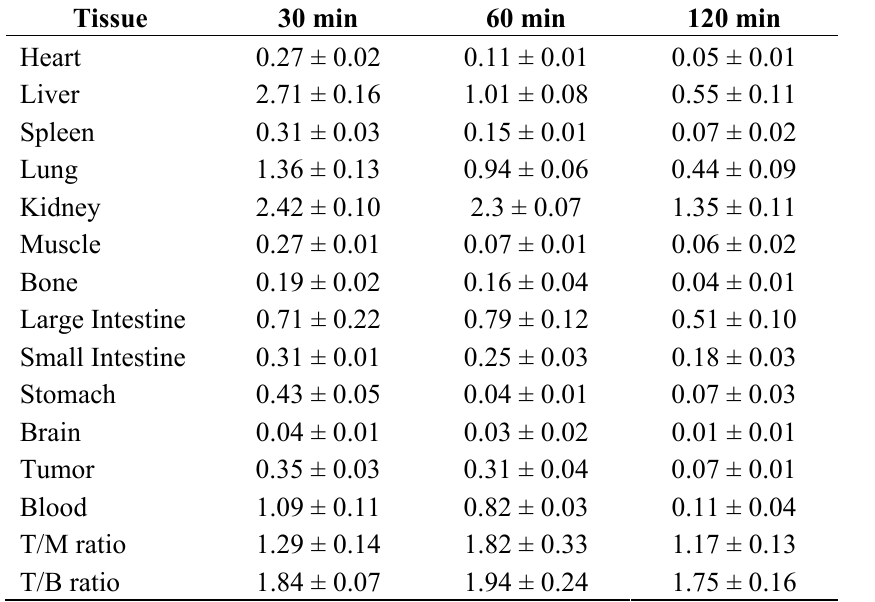
Table 2. Biodistribution of [ 99m TcN]-1 in mice bearing S180 tumor (%ID/g) a